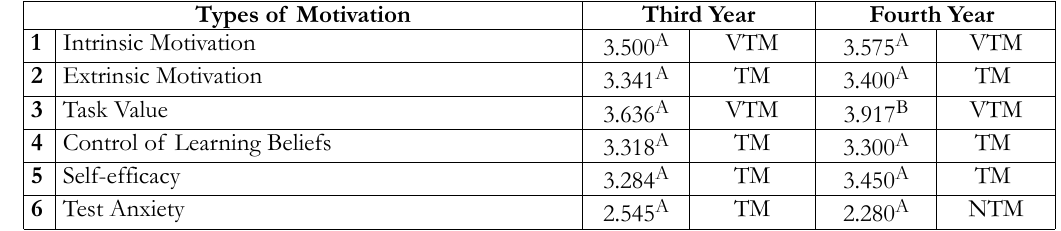
Table 3. The Respondents’ Motivation in Science Learning when Grouped by Curriculum Year 1